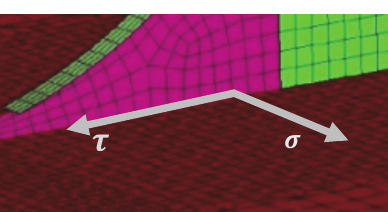
Figure 7: Illustration of the local multiaxial stress components (normal and shear) with respect to a structural detail